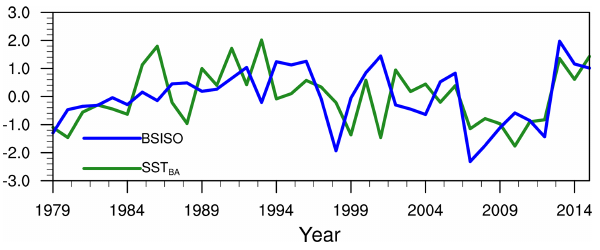
Figure 10. The variation of the normalized BSISO (blue) and November SST BA (green) from 1979 to 2015, after